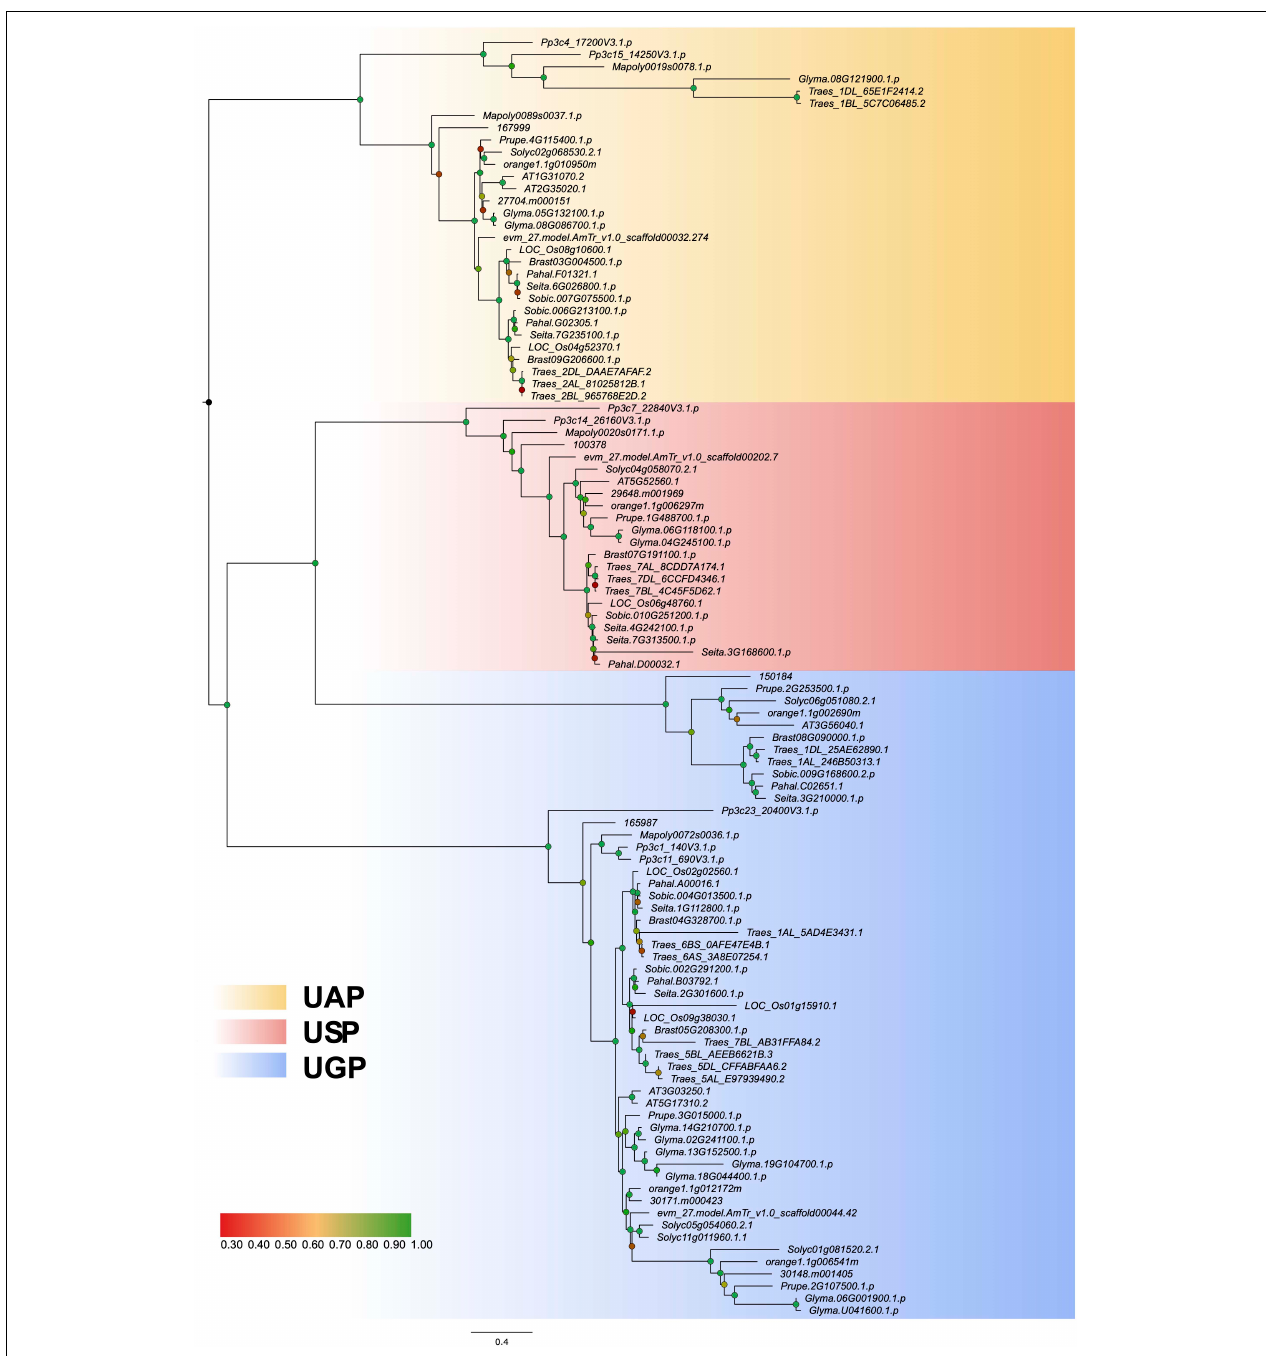
FIGURE 2 | Maximum likelihood phylogenetic tree of UDP glucose pyrophosphorylases (UDPGPs). A maximum likelihood analysis phylogenetic tree illustrates the evolutionary relationships among UDPGP sequences from 16 species representing a wide variety of plant lineages and the ancestral homolog. The three phylogenetic clusters were designated as UDP-N-acetylglucosamine pyrophosphorylase (UAP; yellow), UDP-sugar pyrophosphorylase (USP; red), and UDP-glucose pyrophosphorylase (UGP; blue). Statistical support is shown in corresponding nodes at relevant clades according to the color of the label. Branch lengths in the tree are proportional to evolutionary distances between nodes, and the scale bar represents the number of inferred amino acid substitutions per